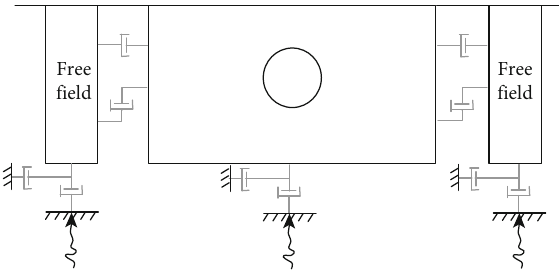
Figure 4: Free- fi eld boundary for dynamic